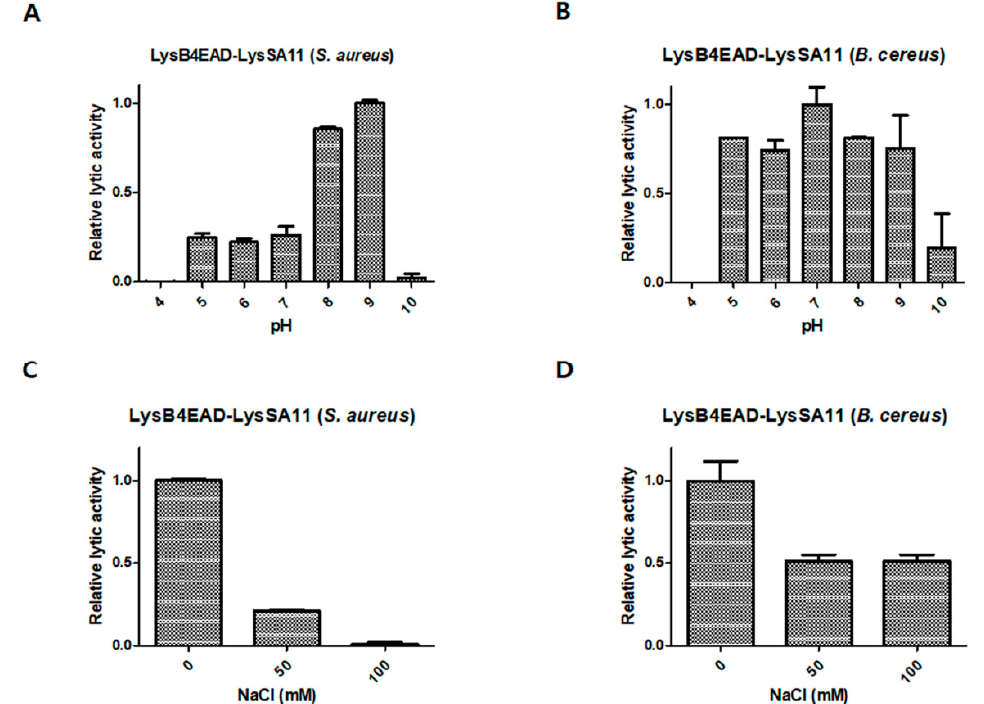
Figure 4. The e ff ect of pH and NaCl on the lytic activity of LysB4EAD-LysSA11. The lytic activity of LysB4EAD-LysSA11 against ( A ) S. aureus RN4220 and ( B ) B. cereus ATCC 21768 was evaluated under di ff erent pH conditions. The lytic activity of LysB4EAD-LysSA11 against ( C ) S. aureus RN4220 and ( D ) B. cereus ATCC 21768 was evaluated at di ff erent NaCl concentrations.